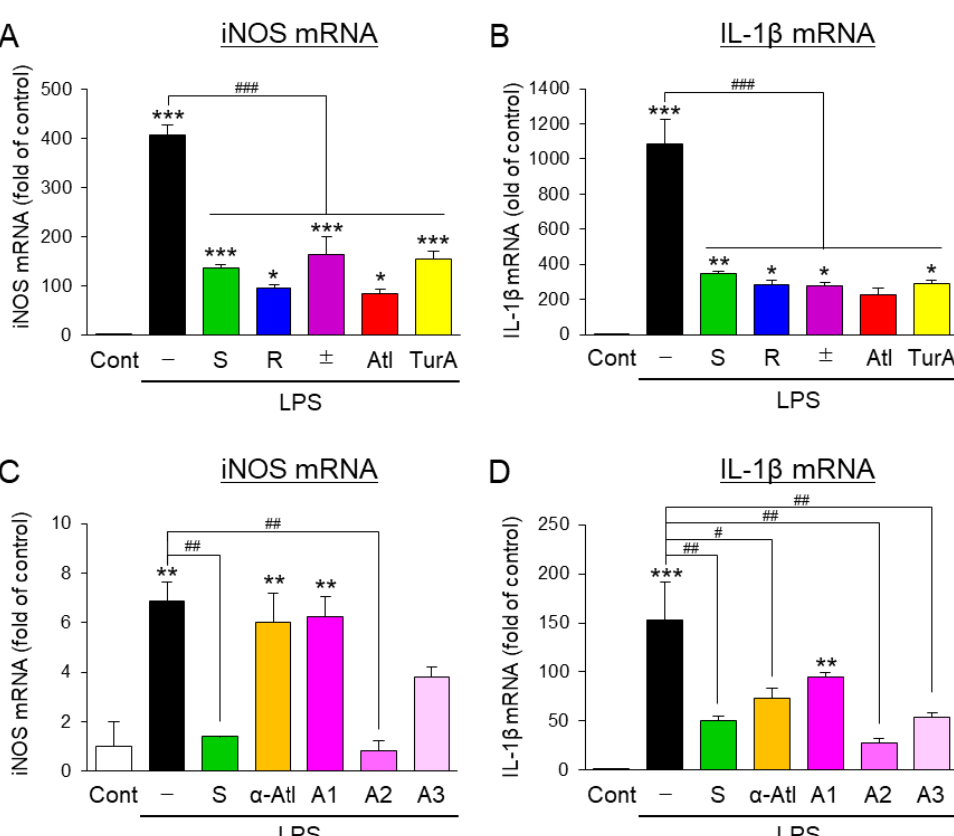
Figure 2. Effects of ar-turmerone analogs on the LPS-induced inflammatory activation of microglial BV2 cells. The mRNA levels of iNOS ( A , C ) and IL-1 β ( B , D ) in BV2 cells were quantified with RT-qPCR. BV2 cells were treated with 10 ng/mL LPS in the presence or absence of 20 µ M ar-turmerone analogs (S-Tur, R-Tur, ± -Tur, Atl, and TurA in A , B , S-Tur, α -Atl, A1, A2, and A3 in C , D ) for 24 h. The data are presented as the mean ± SEM of three independent samples. * p < 0.05, ** p < 0.01, *** p < 0.001 vs. control, # p < 0.05, ## p < 0.01, ### p < 0.001 (n = 3, one-way ANOVA, followed by a post hoc Tukey test).